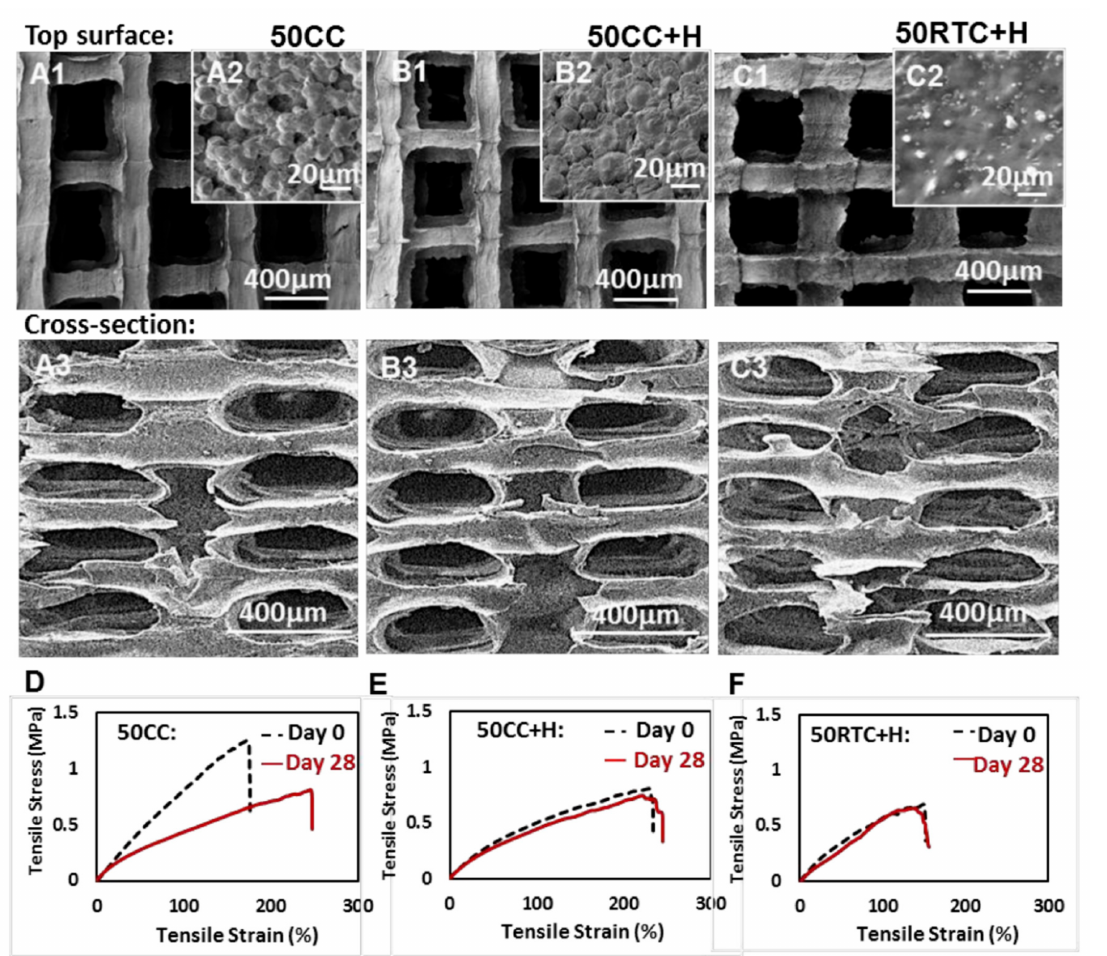
Figure 7. Stiffness memory as visible at stress-strain curves at day 0 and 28 of incubation ( D – F ) and corresponding structures of PUU-POSS scaffolds ( A – C ) obtained at different conditions (samples names assigned above the figure). Reprinted with permission from Wu L.; Magaz A.; Maughan